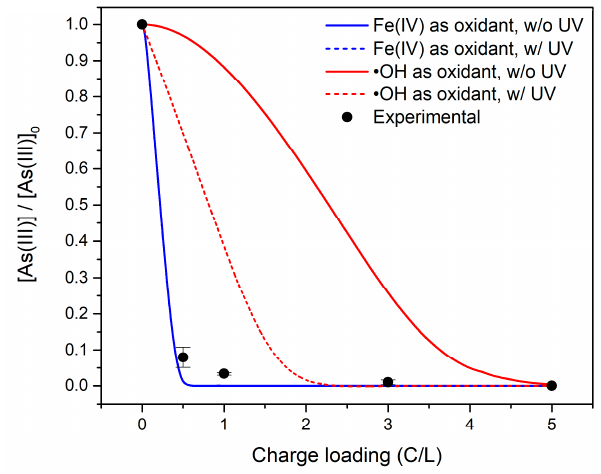
Figure 6. Experimental and simulated fractions of As(III) remaining in solution vs. charge loading employing the mechanism for Fe(IV) and •OH as oxidants, with and without UV irradiation. ( • ) represents experimental data. Solid and dashed lines represent setup without and with UV irradiation, respectively. The blue line represents oxidation by Fe(IV), and the red line represents oxidation by •OH. Note that the blue solid and dashed lines are superimposed. Spectral-averaged specific absorption coe ffi cient, κ = 3.89 m 2 / mol [24]; UV irradiance, I 0 = 38.54 W / m 2 .